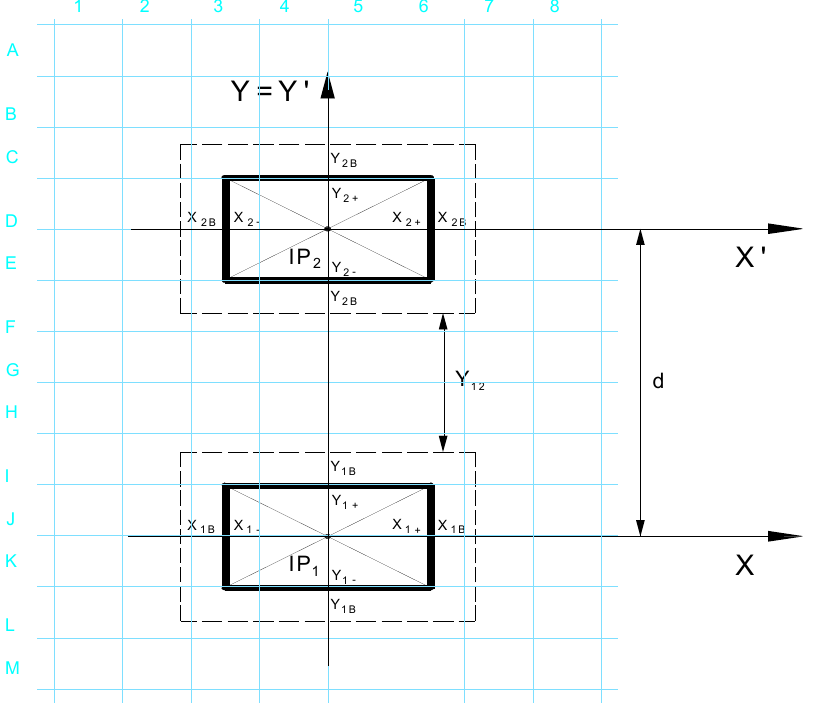
Figure 2. Model of building elements relationships of production systems 1 ‐ 0 y [28]. The insertion point of the construction element of the production system is rotated by an angle α , of the flow line of the insertion points and the axis 0 x .